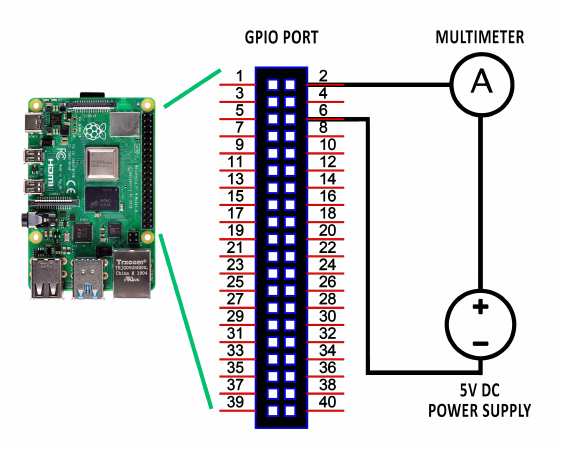
Figure 1. Current measuring